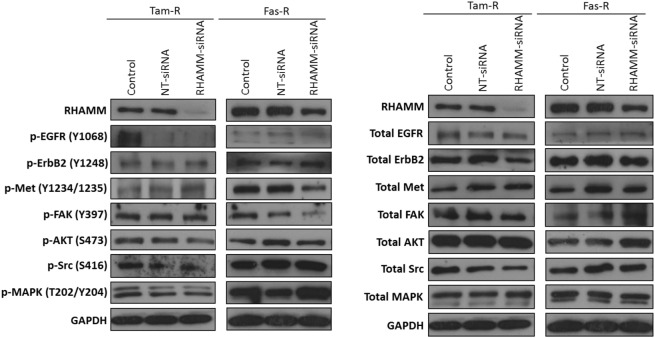
Effects of RHAMM suppression on pathway signaling. Western blotting of cells following treatment with RHAMM siRNA revealed that RHAMM suppression did not significantly alter receptor tyrosine kinase and associated pathway signaling in Tam-R cells; however, Fas-R cells showed modest reductions in Met and FAK activity. No change in total protein levels was observed in the absence of RHAMM.